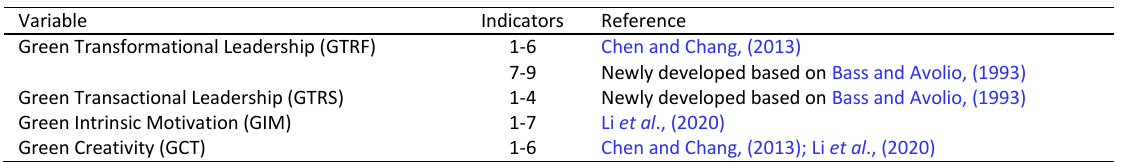
Table 1: Measurement method (questionnaire and scaling)